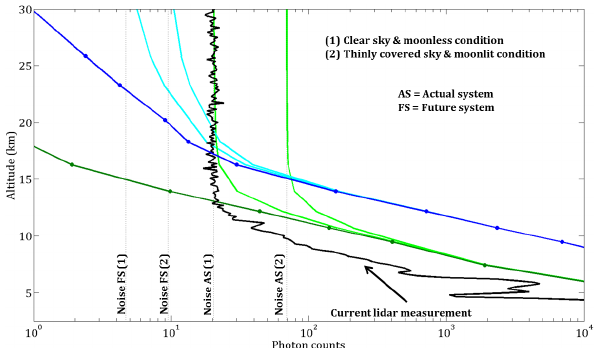
Fig. 15. Raman H 2 O backscattered signal comparison (30 min- Figure 15. Raman H 2 O backscattered signal comparison (30 minutes time integration). The 2 utes time integration). The bold black line with dots corresponds bold black line with dots corresponds to the numerical simulation regarding the current lidar 3 to the numerical simulation regarding the current lidar system and system and the bold black line with square for the future one with one laser. The grey lines 4 the bold black line with a square for the future one with one laser. correspond to the numerical simulation + noise (sky background and detector noise) following 5 The grey lines correspond to the numerical simulation+noise (sky different weather conditions: dark grey lines for the actual system and light grey lines for the 6 background and detector noise) following different weather condi- future system. Weather conditions are indicated on the figure. 7 tions: dark grey lines for the actual system and light grey lines for the future system. Weather conditions are indicated on the